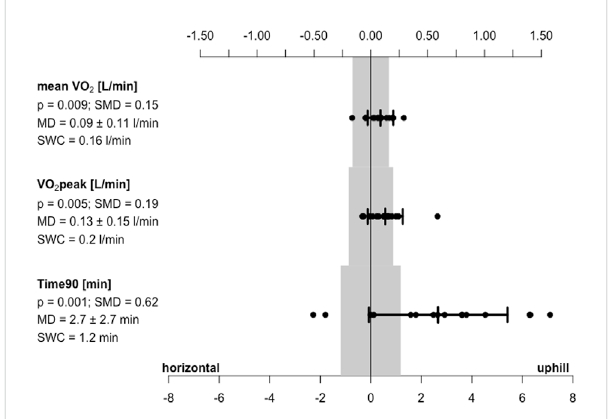
FIGURE 1 Mean difference (MD ± standard deviation) between horizontal and uphill high intensity training protocols for mean oxygen consumption ( _ VO 2 ), peak oxygen consumption ( _ VO 2 peak), and accumulated time above 90% of maximal oxygen consumption (Time90). Smallest worthwhile change (SWC) boundaries are marked in grey. Signi fi cance levels ( p ) and pairwise effect sizes as standard mean differences (SMD) are